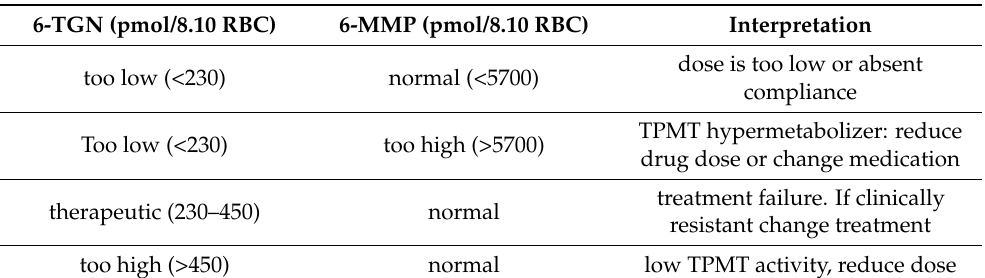
Table 2. Overview of drug